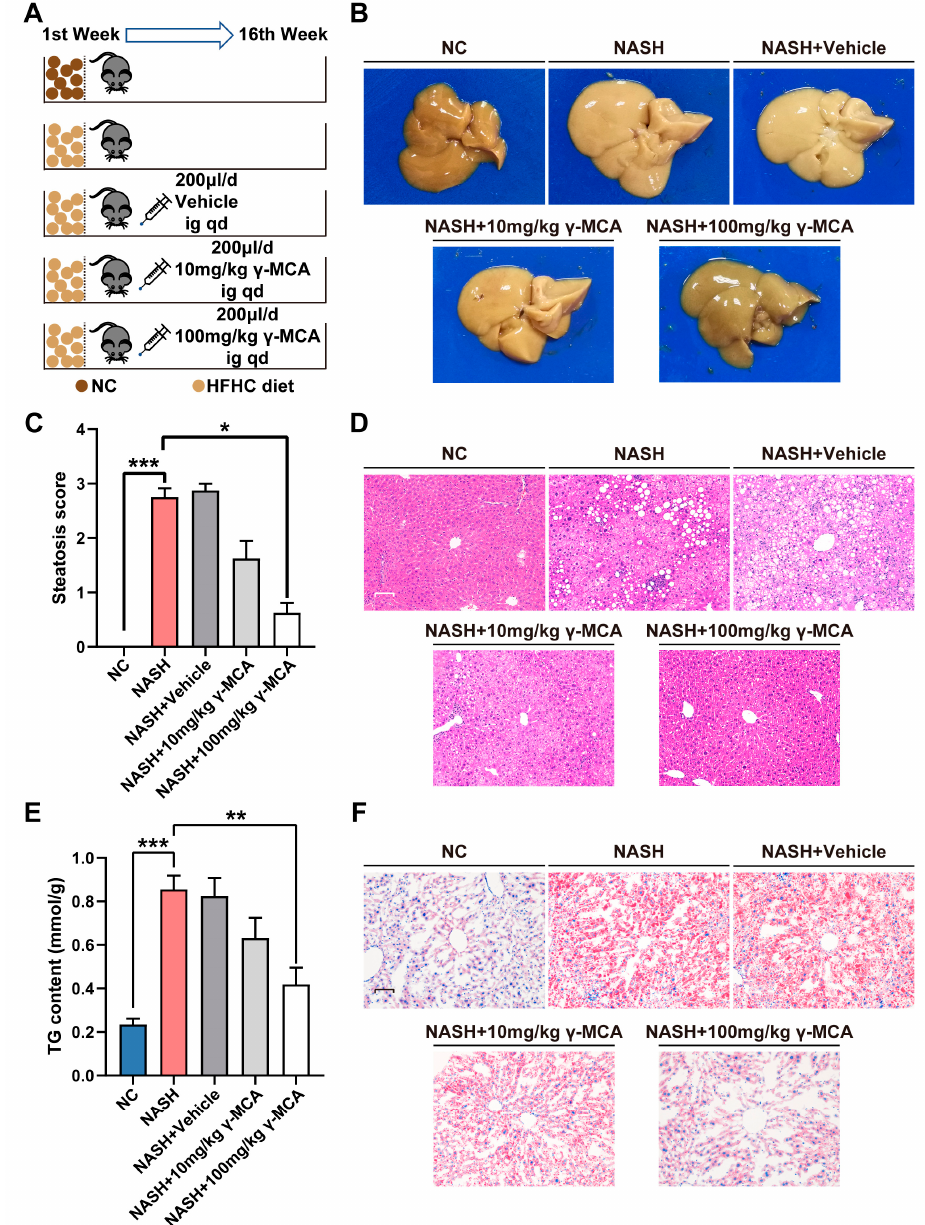
Figure 3. γ -MCA relieved the HFHC diet-induced hepatic steatosis in mice. ( A ) Except for those in the NC group with a normal diet, mice in the NAFLD, NAFLD + Vehicle, NAFLD + 10 mg/kg γ -MCA, and NAFLD + 100 mg/kg γ -MCA groups were exposed to a high-fat high-cholesterol (HFHC) diet for 16 weeks. When compared to the intragastric administration of vehicle (200 µ L/day) in the NAFLD + Vehicle group, the NAFLD + 10 mg/kg γ -MCA and NAFLD + 100 mg/kg γ -MCA groups were treated by gavage of 10 mg/kg and 100 mg/kg γ -MCA in vehicle, respectively. ( B ) An enlarged liver, with a blunted edge and yellow-in-color, featured the gross appearance of the NAFLD group, whereas improvements were shown in the NAFLD + 10 mg/kg γ -MCA and NAFLD + 100 mg/kg γ -MCA groups. ( C , D ) Both steatosis score ( C ) and H and E staining ( D ) demonstrated the occurrence of hepatic steatosis in the NAFLD group and its resolution in the NAFLD + 10 mg/kg γ -MCA and NAFLD + 100 mg/kg γ -MCA groups (scale bar: 50 µ m). ( E , F ) Both TG analysis ( E ) and Oil Red O staining ( F ) characterized the lipid accumulation in the NAFLD group, and the lipolysis in NAFLD + 10 mg/kg γ -MCA and NAFLD + 100 mg/kg γ -MCA groups (scale bar: 50 µ m). The data were presented as the mean ± SEM. *, p < 0.05; **, p < 0.01; and ***, p <